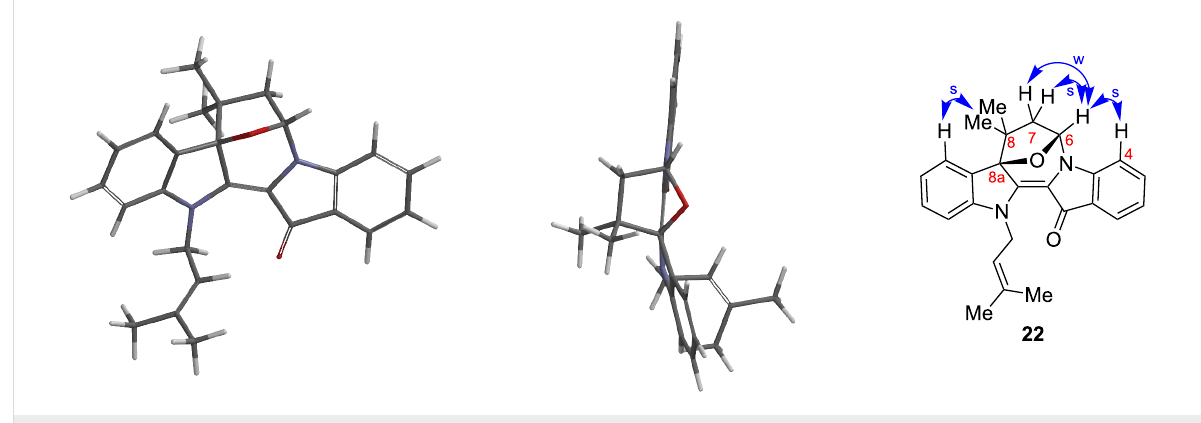
Figure 3: Modelled structure (Spartan 10, v1.1.0, Wavefunction Inc) of bridged indigo-tetrahydrofuran product 22 . Left: top view showing the tetrahy- drofuran ring sitting directly over the indigo skeleton (vertical), which itself is twisted from planarity. Middle: front view. Right: NOESY correlations in support of the proposed structure (s = strong; w = weak).